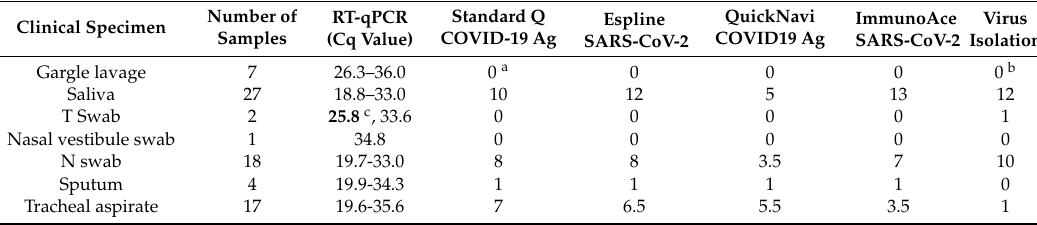
Table 3. Sensitivity of rapid antigen tests for di ff erent types of clinical specimen.